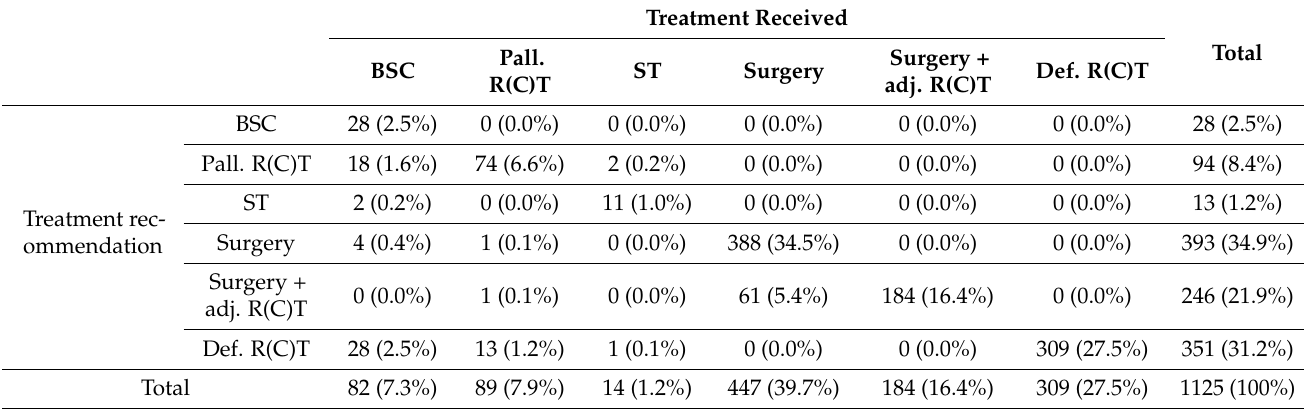
Table 2. Cross-table comparing the recommended therapy to the received therapy.